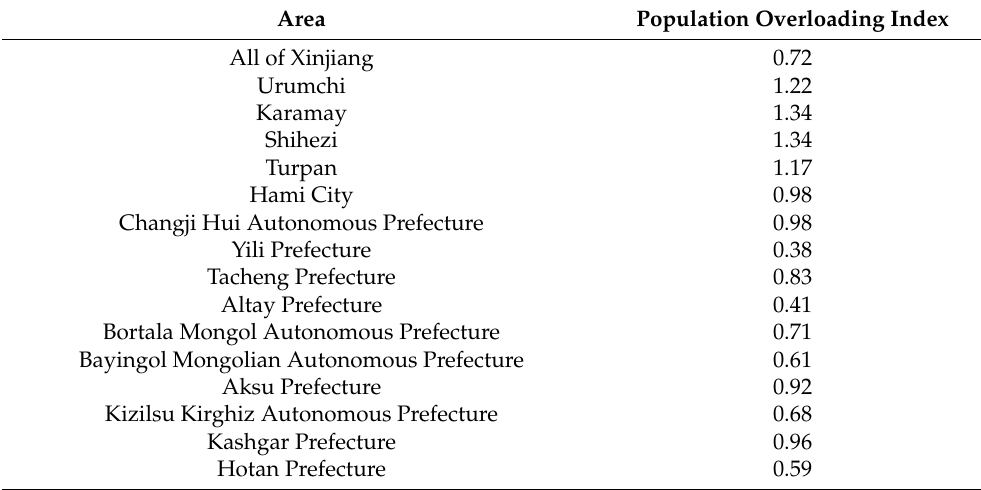
Table 2. The Population Overloading Index of Xinjiang in